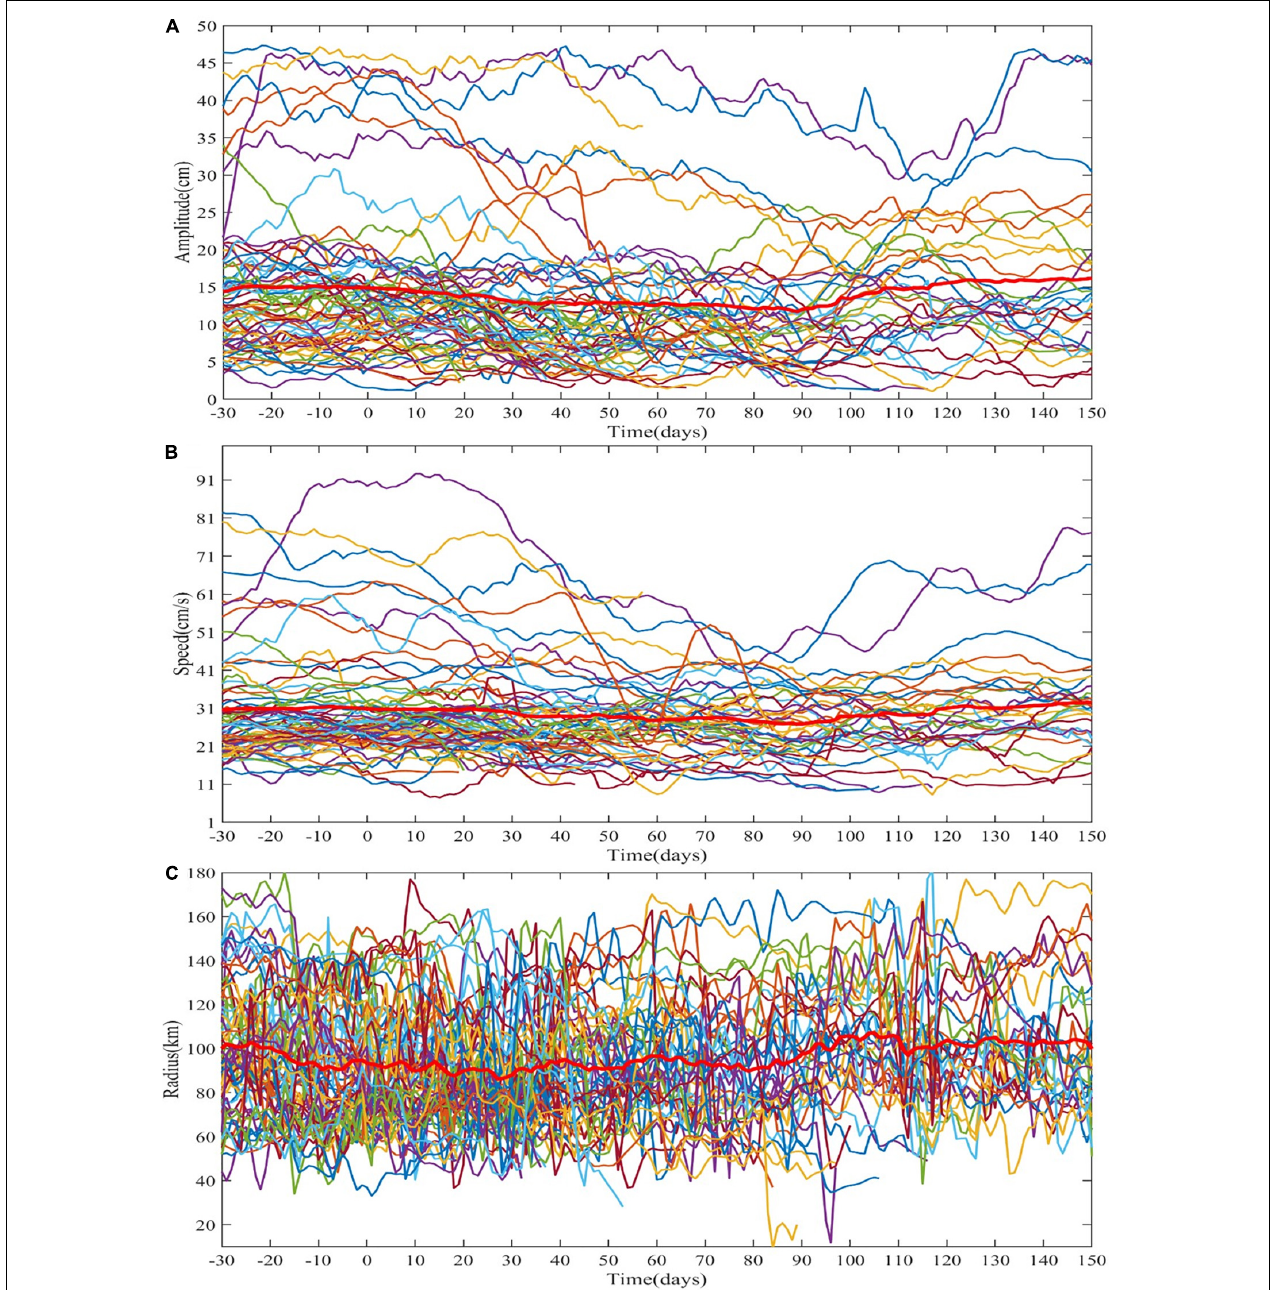
FIGURE 3 | The intrinsic attribute curves of 69 mesoscale eddies. (A) Amplitude curves of 69 mesoscale eddies after spatial normalization. (B) Rotation speed curves of 69 mesoscale eddies after spatial normalization. (C) Radius curves of 69 mesoscale eddies after spatial normalization.